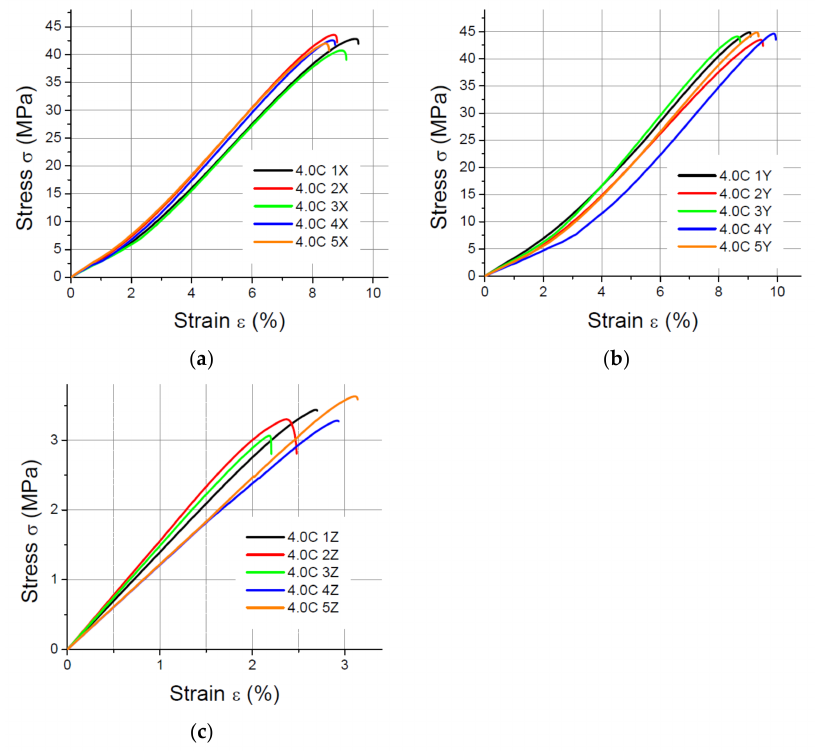
Figure 11. Tensile test results for 4 mm thick specimens made of PLA-CF printed in ( a ) the X orientation; ( b ) the Y orientation; ( c ) the Z